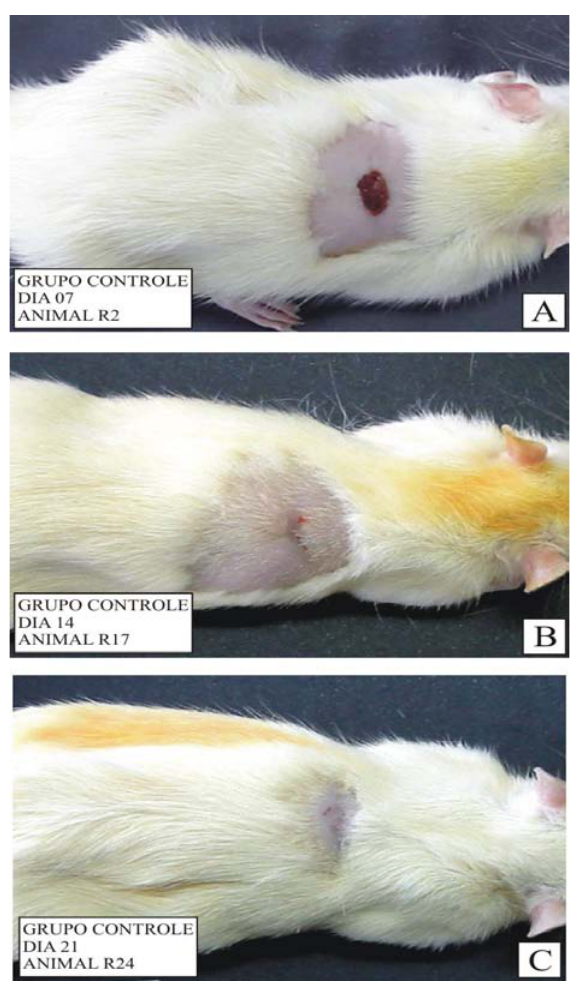
FIGURA 2 - Fotos de animais do grupo controle mostrando as lesões cutâneas no 7º (A), 14º (B), 21º (C) dias do pós-operatório